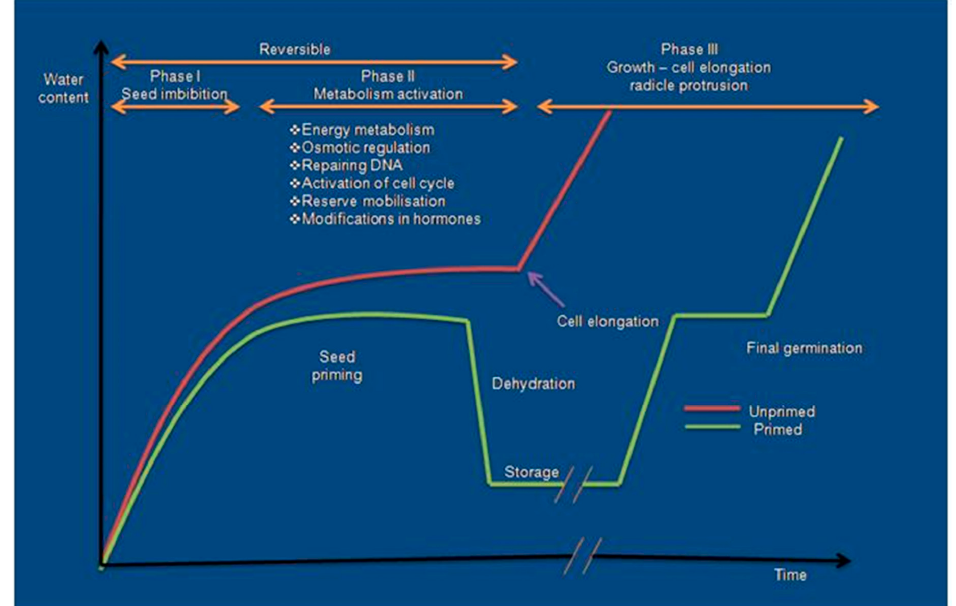
Figure 3. Seed imbibition curves and phases of seed germination in unprimed and primed seeds.